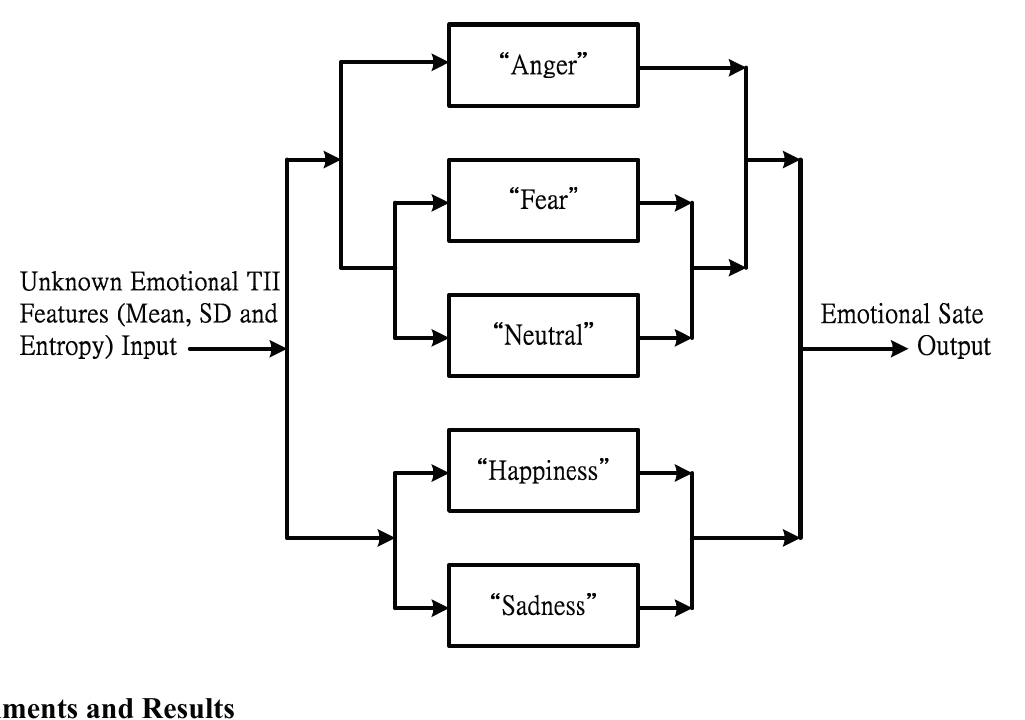
Figure 6. The classification decision applying in